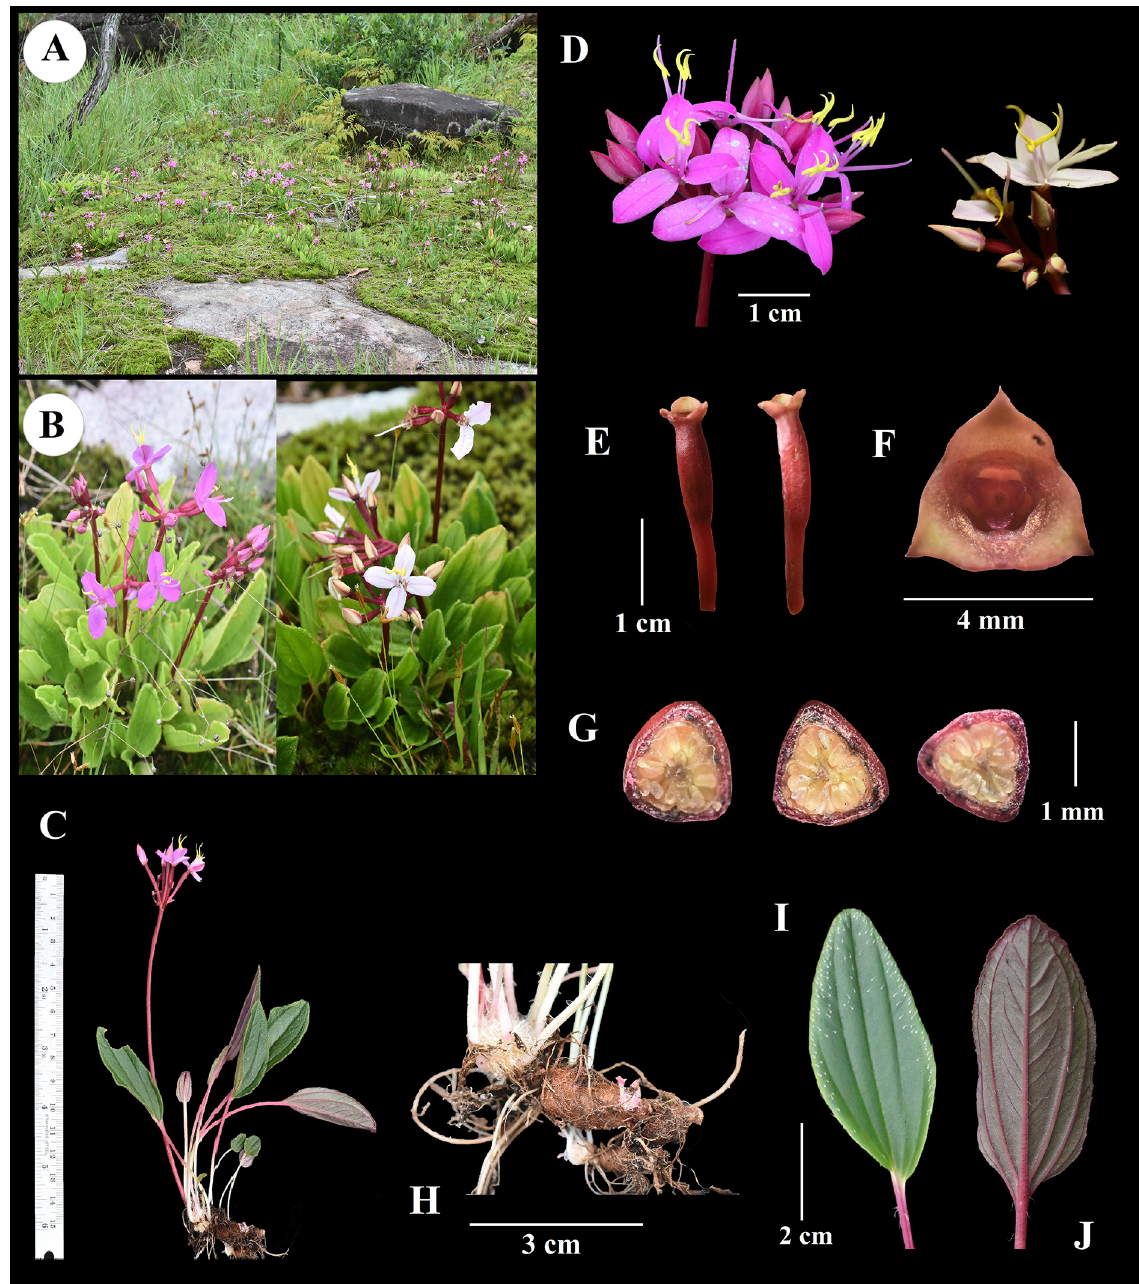
Fig. 2. Sonerila erectifolia Phonep., Soulad. & Tagane sp. nov. A . Habitat (on open moss-covered bedrock). B . Close-up of plant (left: pink flowers, common; right: white flowers, rare). C . Habit. D . Inflorescence (left: pink flowers; right: white flowers). E . Young fruits. F . Top view of young fruit. G . Cross sections of young fruit. H . Rhizome. I . Upper surface of lamina. J . Lower surface of lamina. Photos by P. Phonepaseuth on 17 September